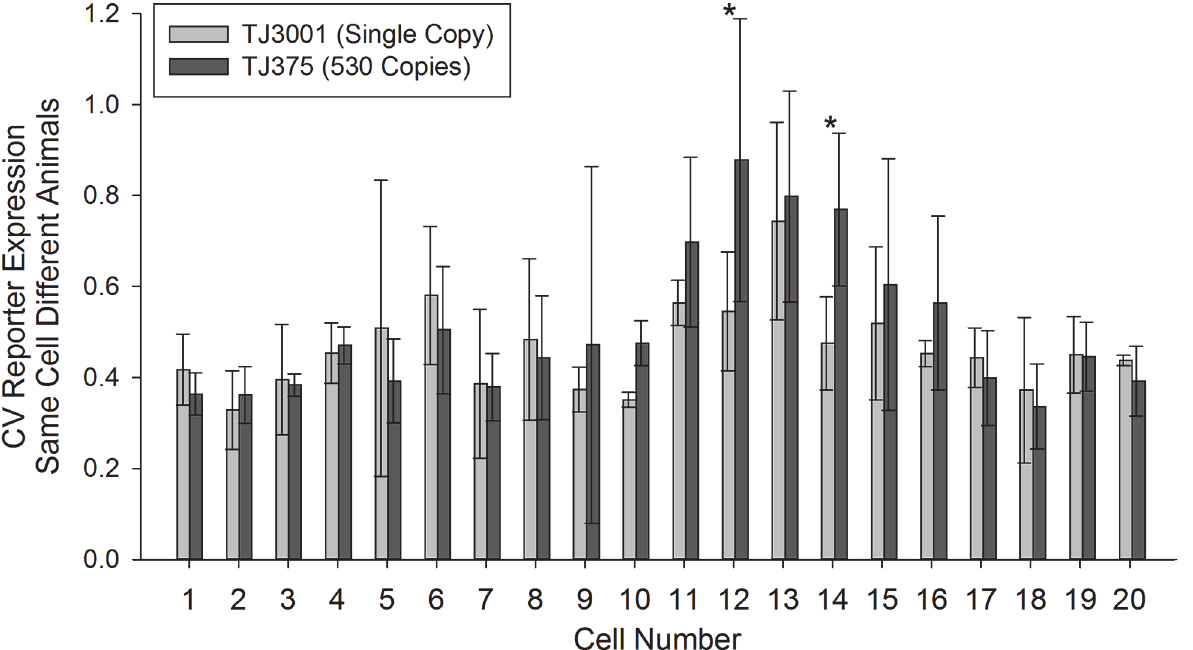
Fig 5. Variation in expression among the same cells in different animals. Plot shows variation in P hsp-16 . 2 - GFP expression for each of the twenty intestine cells by image cytometry (3 CV values per cell, with each CV derived from 8 – 11 measures). X axis shows cell identity (detailed in Figs 2 and S1). Bars show average coefficient of variation. Error bars show standard deviation. Stars above bars indicate significant differences in CV ( P < 0.022; Two-Way Repeated Measures ANOVA followed by a Holm-Sidak comparison procedure) between the two reporters in Cell 12 (int5L) and Cell 14 (int6L).